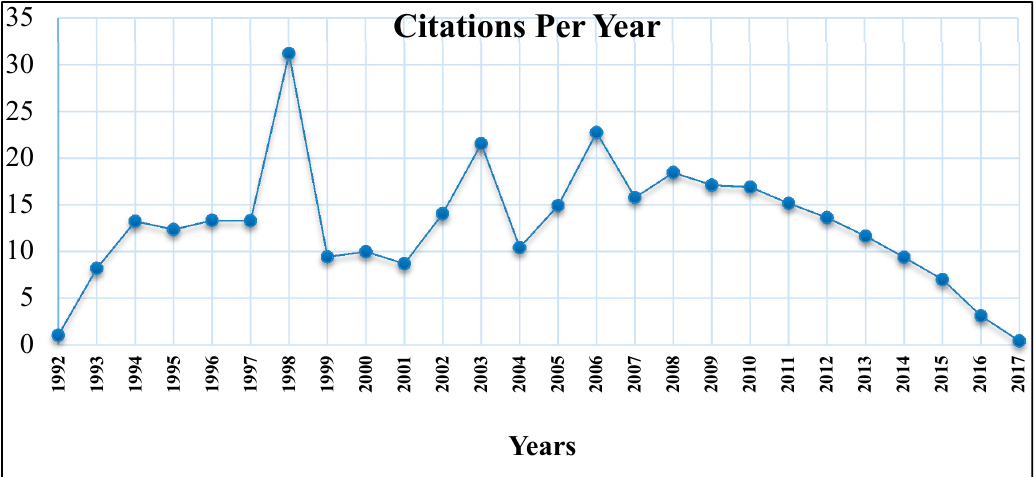
Figure 3. Citations per year of the NC computing. Table 1. General citation Structure in the Journal: NC (1992–2018).